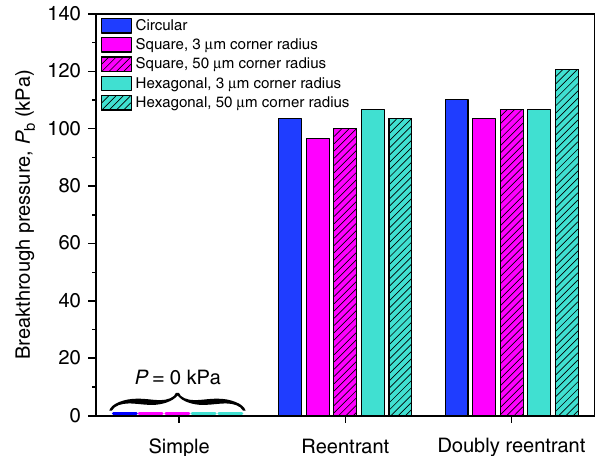
Fig. 6 Breakthrough pressures of different microtextures. Breakthrough pressures for SCs, RCs, and DRCs of different shapes and primary dimension, D = 200 µ m measured with water as the probe-liquid at NTP within seconds after immersion (to minimize the effects of